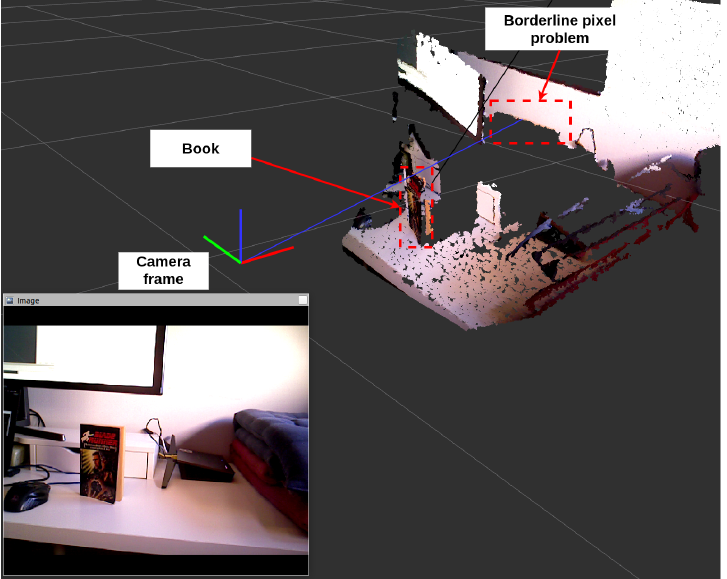
Figure 3. At the bottom left, we show the segmented image in RViz https://github.com/ros- visualization/rviz (accessed on 21 January 2021). The rest of the figure shows the corresponding point cloud. The Boundary point problem appears at the edges of the segmented areas. As seen in the point cloud, some points belong to the book whose positions are on the back